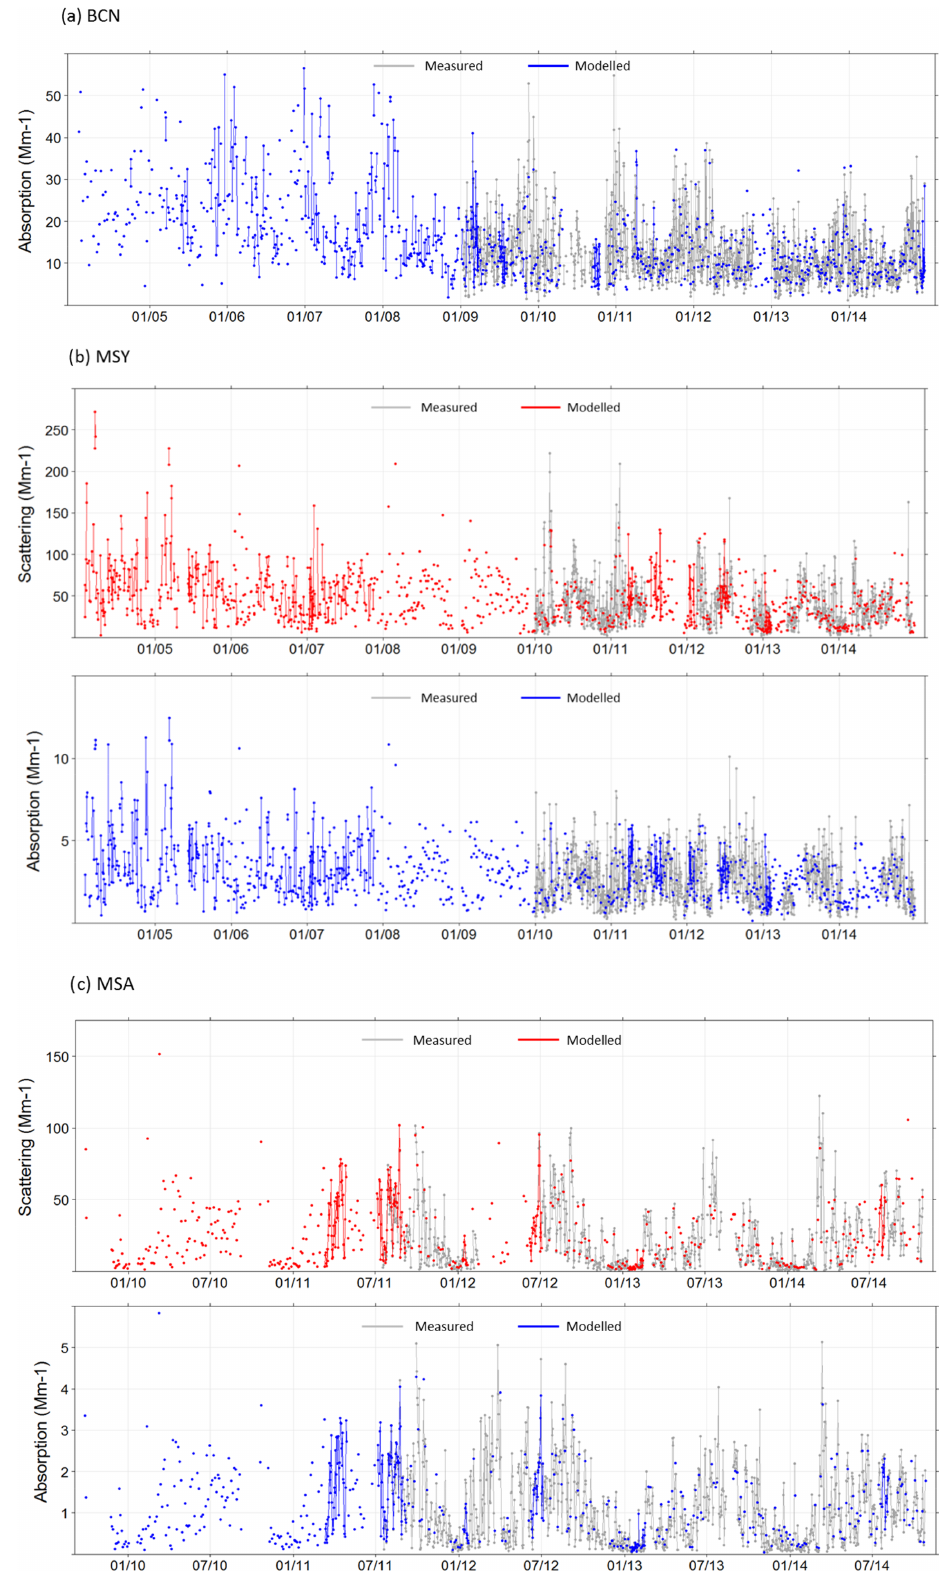
Figure 7. Time series of the daily average modelled and measured extensive optical coefficients (scattering at 525nm and absorption at 637nm) for (a) BCN and (b) MSY during the period 2004–2014, and for (c) MSA during the period